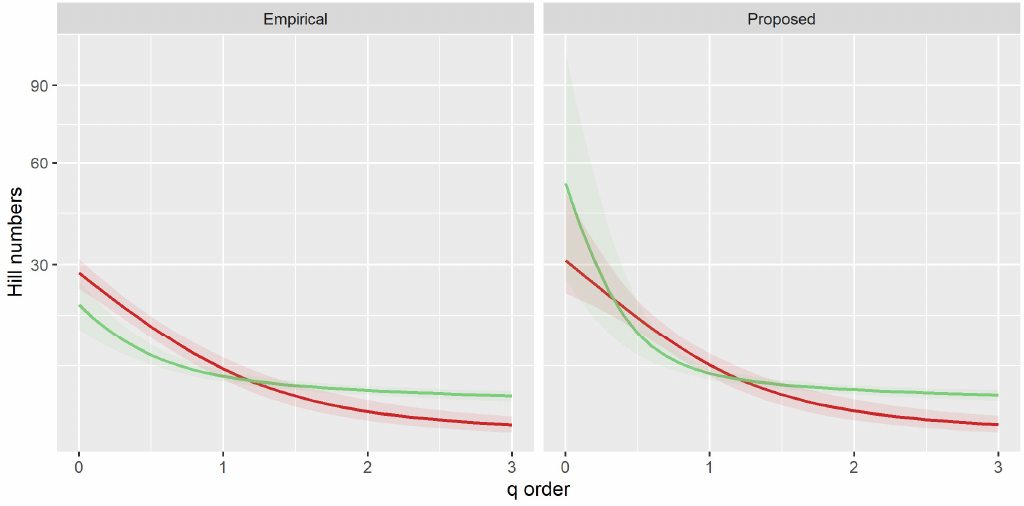
Figure 2. Empirical and proposed diversity profiles based on the q statistic for fruit-feeding butterfly assemblages for the canopy (red line) and understory (green line) sampled in mixed ombrophilous for- est in southern Brazil during November 2016–March 2017 and October 2017–March 2018. Confidence intervals (95%) were constructed on the basis of bootstrap resampling (1000